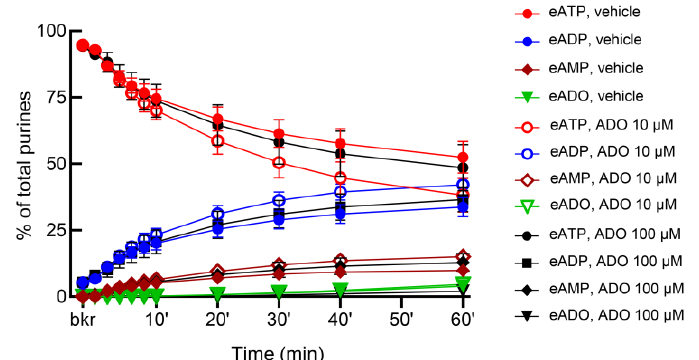
Figure 14. Effects of adenosine (ADO) on the release of soluble nucleotidases in lamina propria of distended denuded bladder preparations. eATP decrease and eADP, eAMP, and eADO increase after addition of eATP to concentrated ELS collected at the end of bladder filling. Note that there is no significant difference between eATP degradation in ELS from bladder preparations treated with vehicle (KBS, n = 9) and adenosine ( n = 4 each); n , number of bladder preparations.